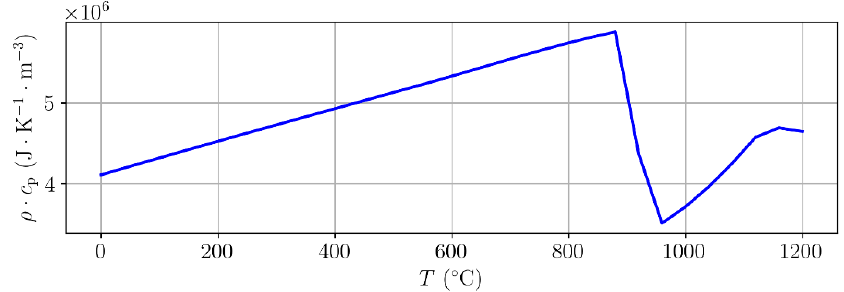
Figure 3. Temperature dependence of specific heat (steel S355).